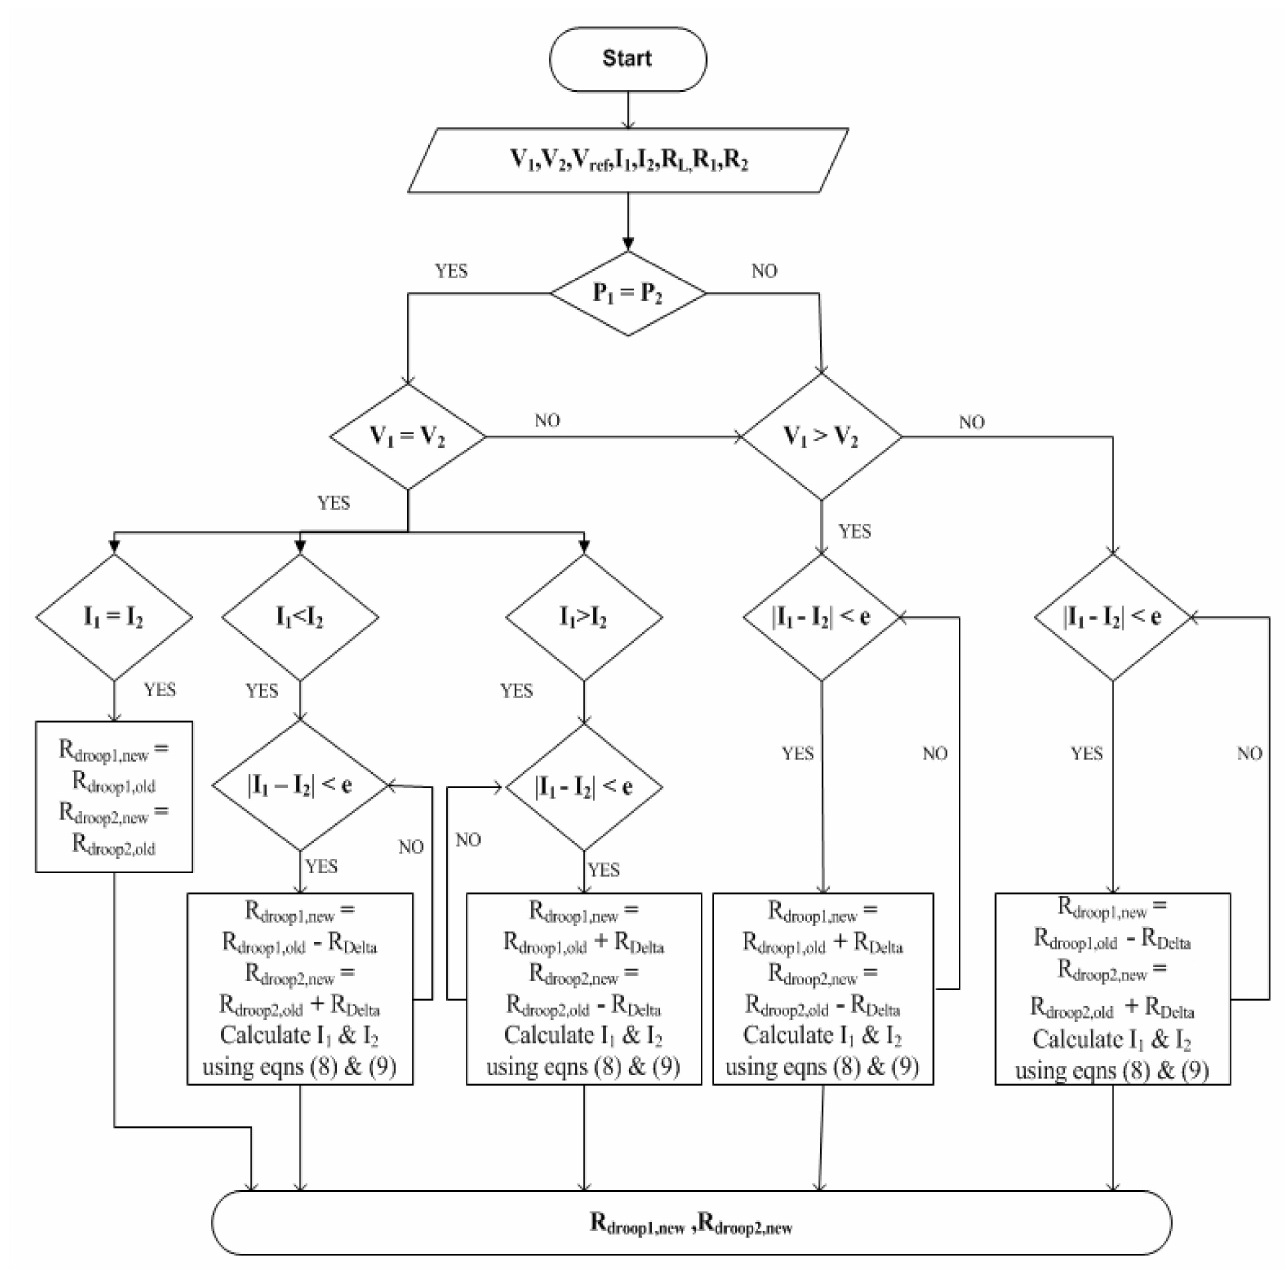
Figure 5. Proposed drop control